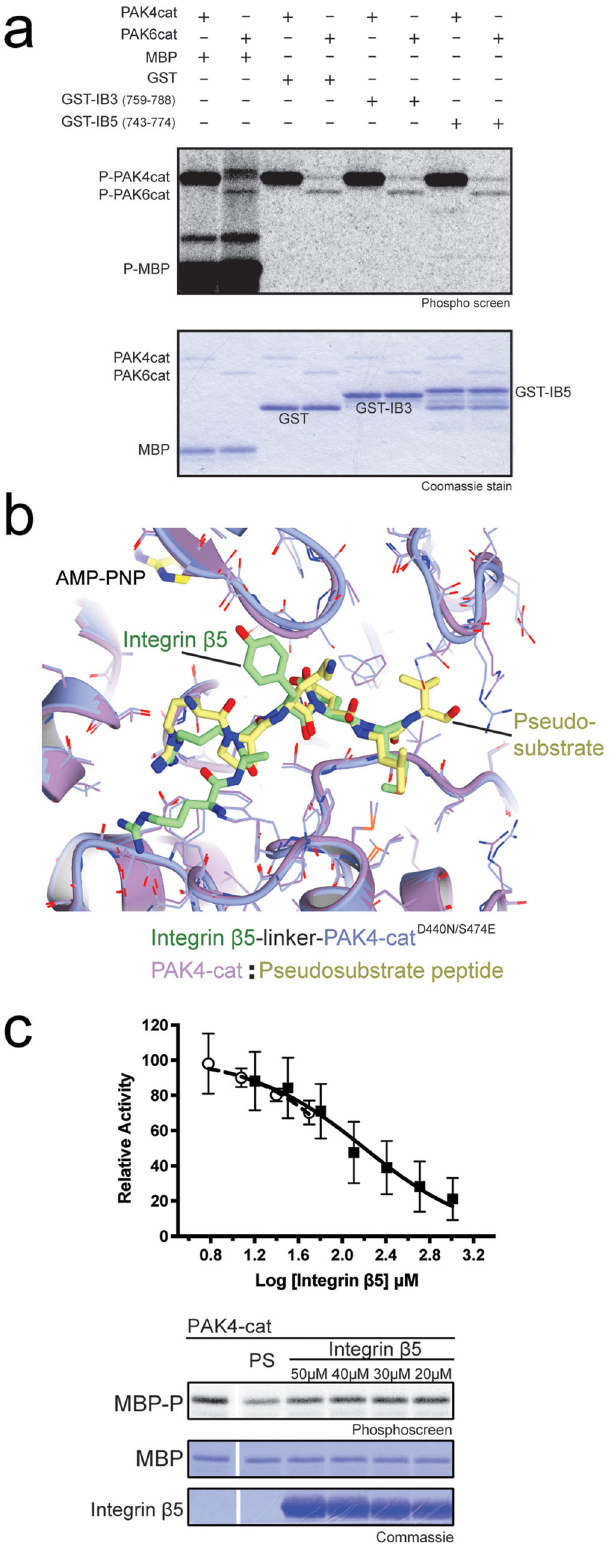
Fig. 5 In vitro impact of integrin β 5 cytoplasmic tail on PAK4 kinase activity. a PAK4 phosphorylates maltose binding protein and autophosphorylates itself, however, it shows little evidence of robust phosphorylation of phosphorylation of GST and a GST-fusion of integrin β 5 encompassing residues 743 – 774. PAK4 also shows little evidence of robust phosphorylation of GST-integrin β 3 (residues 759-788). Activity of PAK6 catalytic domain is shown for comparison. b Superposition of integrin β 5 bound PAK4 with the structure of autoinhibitory pseudosubstrate bound PAK4cat (PDB: 4FII) showing a similar substrate binding groove is occupied. c Titration of full-length integrin β 5 cytoplasmic tail suppresses PAK4cat phosphorylation of MBP (clear circles) with autoradiography and Coomassie stains shown. PS refers to 0.05 µ M pseudosubstrate control peptide (RPKPLVDP) 25 . N = 3. Titration of 11mer integrin β 5 peptide (ERSRARYEMAS) to inhibit phosphorylation of LIMK1 10mer peptide (RKKRYTVVGN) in the presence of 1 mg/ml BSA (black squares). N = 6. SD shown. Source data are provided as a Source Data fi